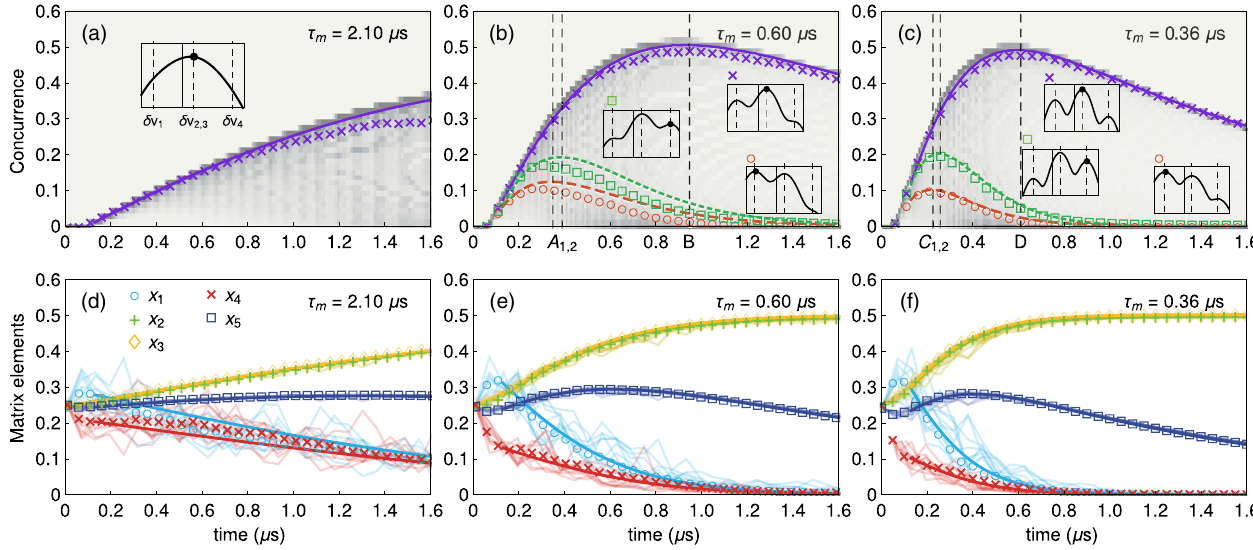
FIG. 3. The most-likely paths from the theoretical prediction and the experimental data. The first, second, and third columns are from three different data sets, measuring the same qubits and cavities with three different measurement-readout powers (indicated by the 2 . 10 μ s, 0 . 60 μ s, and 0 . 36 μ s, respectively. Panels (a) – (c) show the concurrence of the multiple characteristic measurement time): τ m ¼ most-likely paths: the path with high concurrence (solid purple line), and the two paths with low concurrence projecting onto j 00 i (dashed orange line) and j 11 i (dotted green line) subspaces. The vertical lines (labeled as A 1 , B , C 1 , D ) represent the times at which ; 2 ; 2 the concurrence is maximum for each of these paths. The insets show the log-likelihood density as functions of optimal measurement readouts, and the grey-scale histograms in the background show experimental concurrence histograms similar to the one in Fig. 2(c). Panels (d) – (f) present the evolution of the density matrix elements of the high-concurrence most-likely paths: The solid curves indicate theoretical solutions, whereas the data points indicate experimental most-likely paths postselected with the most entangled state at the final time T ¼ 1 . 6 μ s. Examples of the postselected trajectories are shown as fluctuating